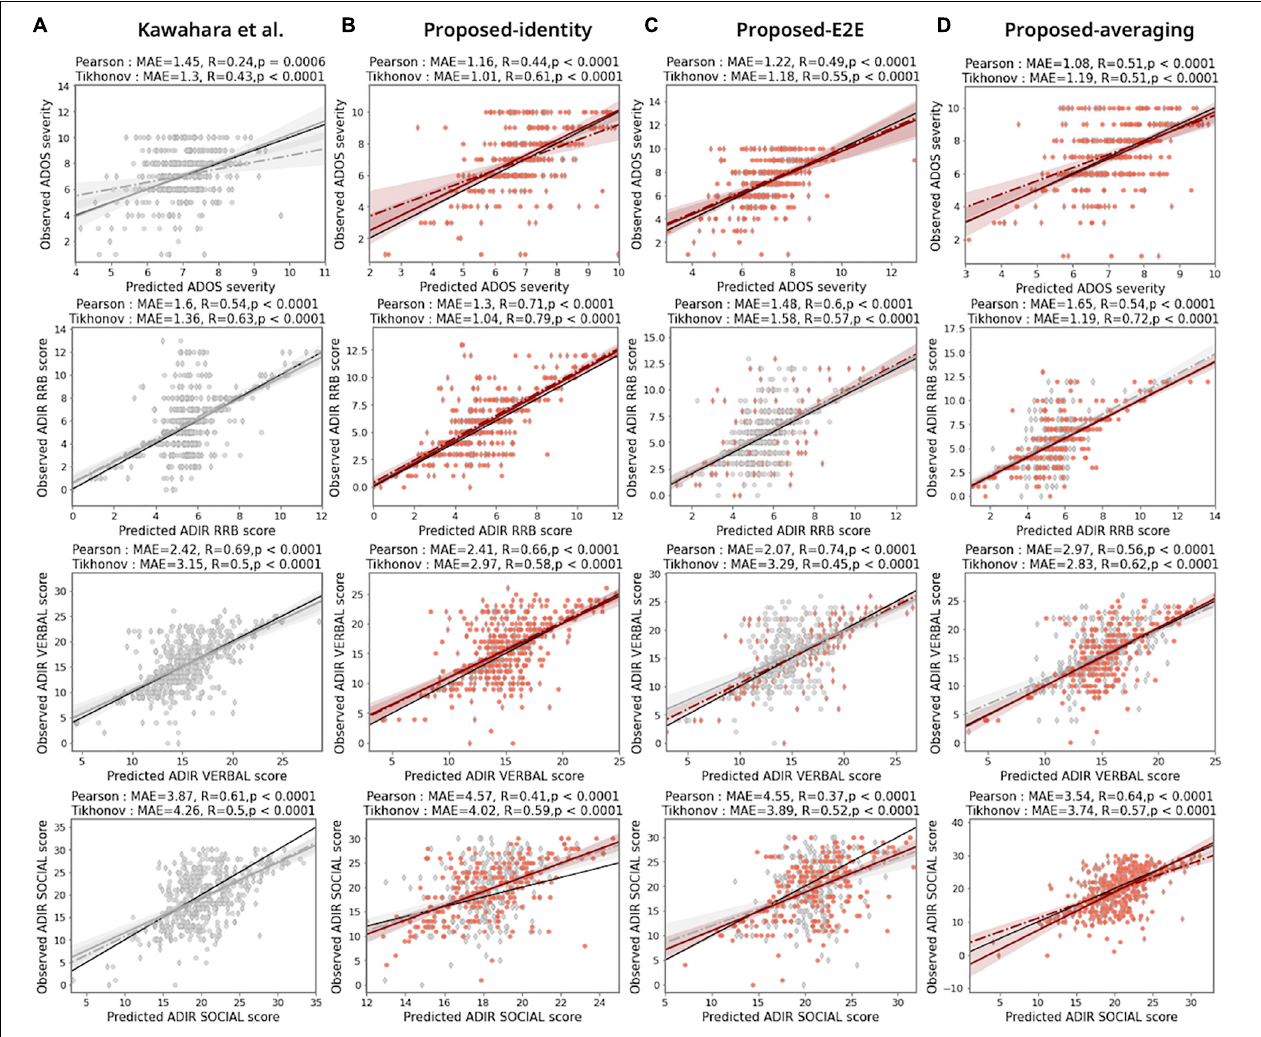
FIGURE 3 | Prediction performances for the proposed model. Comparison of ASD prediction results for benchmarking BrainNetCNN model [Kawahara et al. (2017): panel (A) ] and different configurations of proposed model [panels (B–D) ] under two functional connectivity settings based on the Pearson correlation coefficient (diamond markers and dashed line of best fit) and the Tikhonov covariance (circle markers and solid line of best fit). MAE is the mean absolute error between predicted severity scores and observed severity scores. R and p indicate the Pearson correlation coefficient and corresponding statistical significance between predicted severity scores and observed severity scores, respectively. The colors of the markers and lines mean the increase (red) or decrease (gray) MAE of prediction compared with the benchmarking model. Black solid line in each panel indicates the line with slope of 1. The AAL atlas were used to define the node